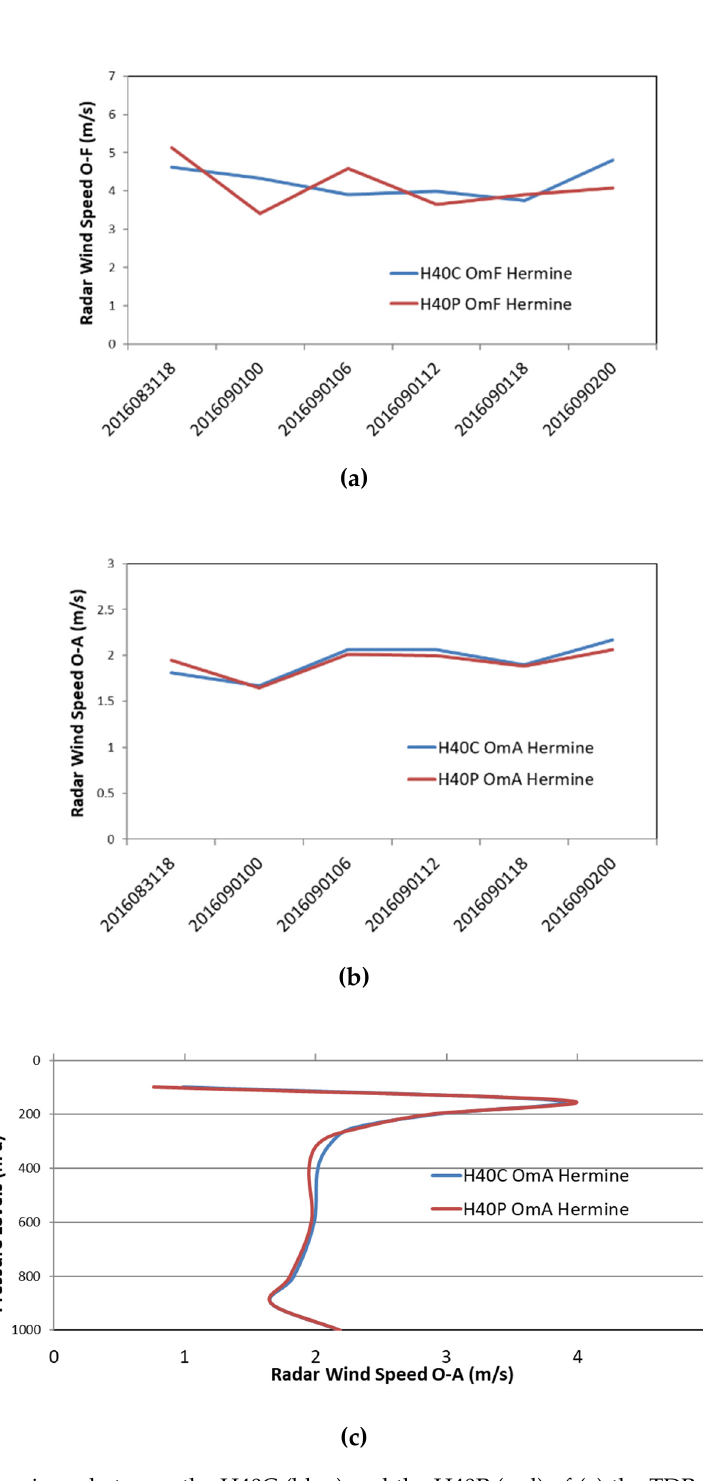
Figure 6. Comparisons between the H40C (blue) and the H40P (red) of ( a ) the TDR radial velocity observation-minus-first-guess (OmF), ( b ) the TDR radial velocity OmA, and ( c ) the TDR radial velocity average of the Observation-minus-Analysis (OmA) vertical profiles, for Hurricane Hermine, 2016.